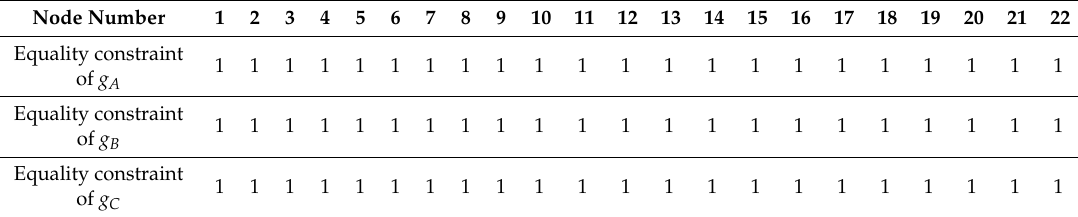
Table 6. Optimum placement of ATCTrs (solution D).